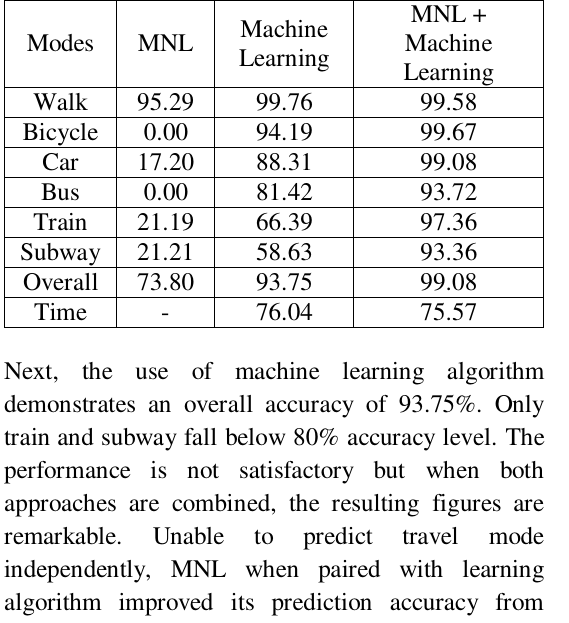
Table 3: Prediction Results (%) using MNL, Machine Learning and